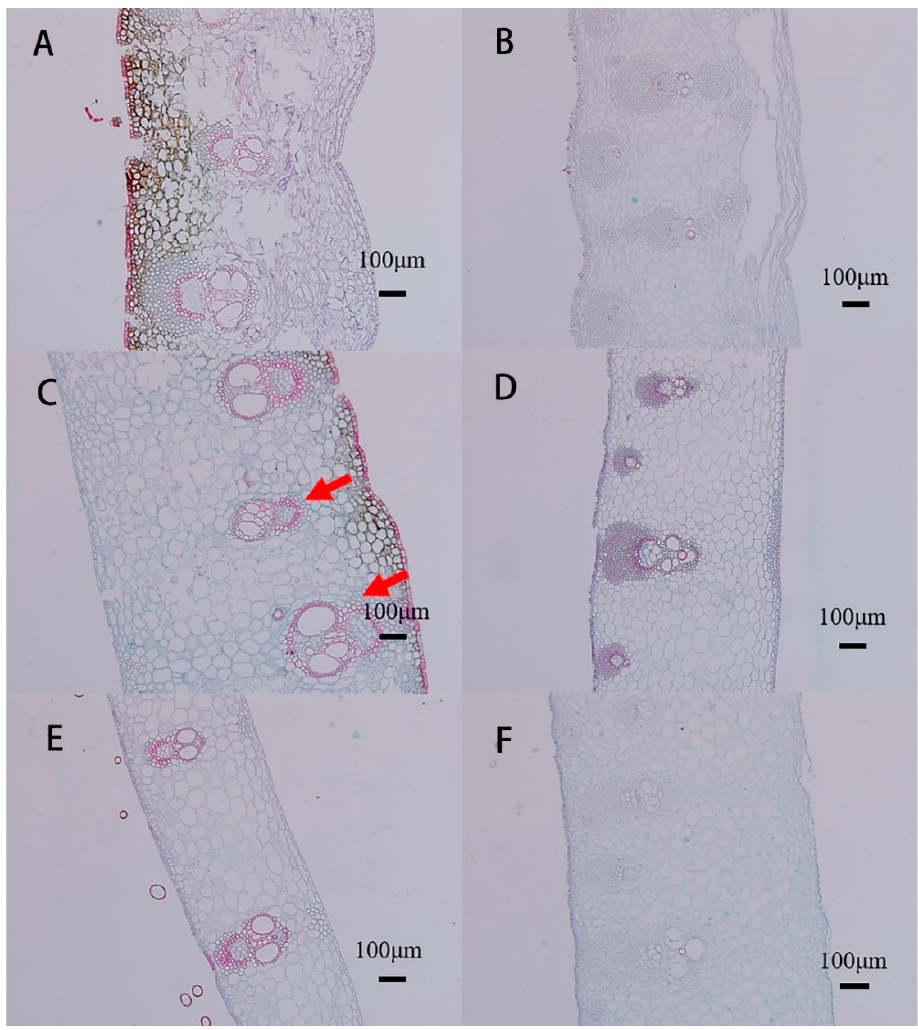
Figure 4. Anatomy of the culm sheaths. ( A , B ) Sheath upper and sheath base of the culm sheath at the base of the bamboo shoot. ( C , D ) Sheath upper and sheath base of the culm sheath at the middle of the bamboo shoot. ( E , F ) Sheath upper and sheath base of culm sheath at the top of the bamboo shoot, large and small vascular bundles (red arrow).